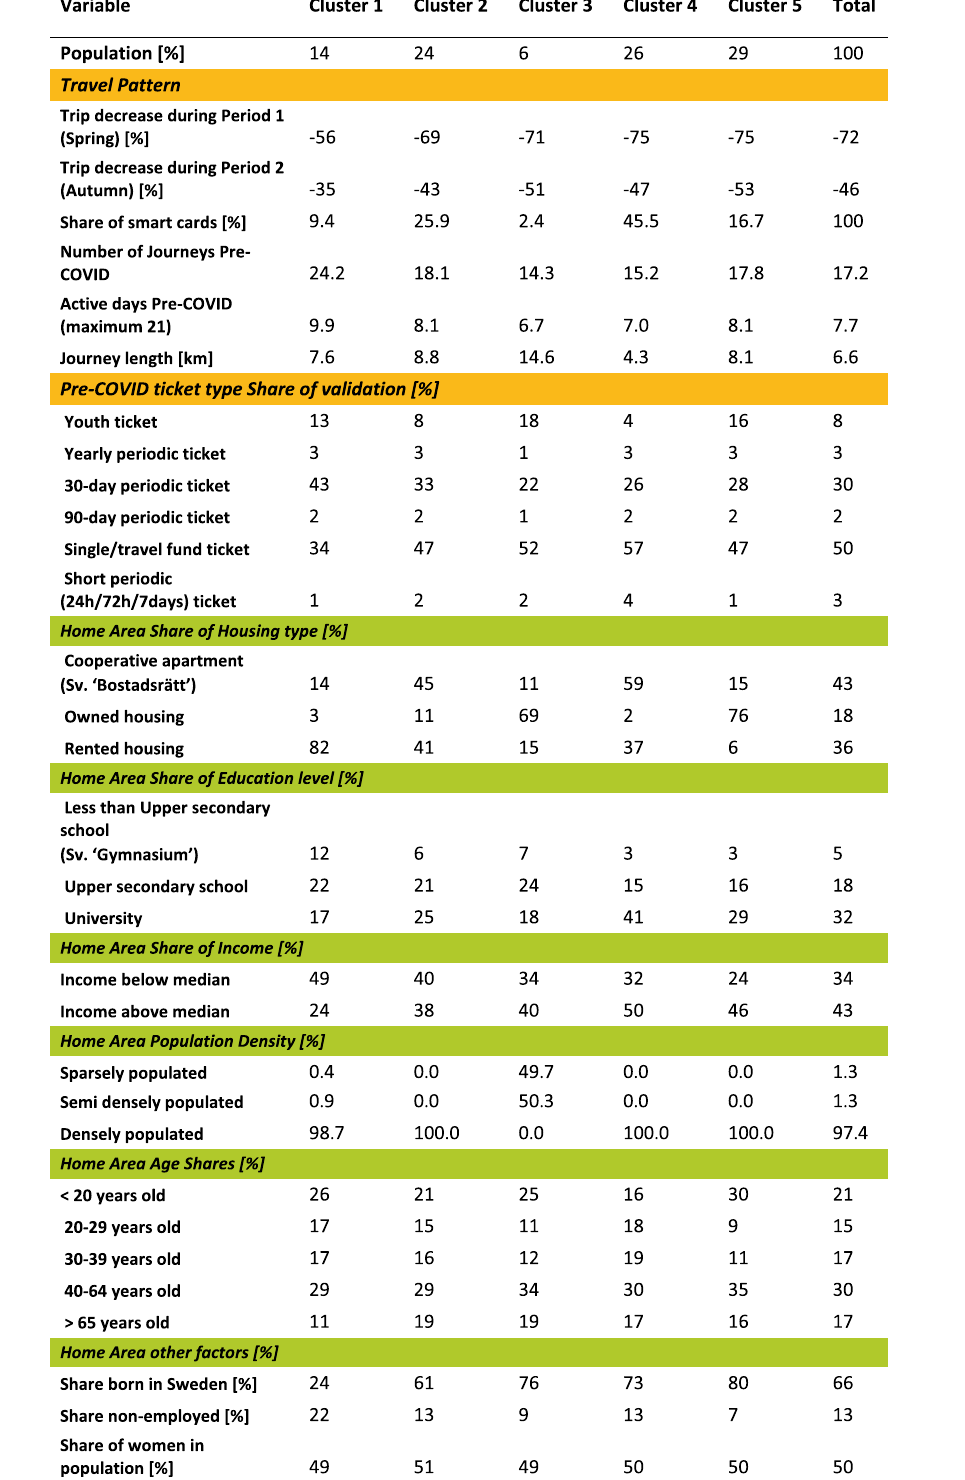
Table 2 The full dataset has 1.8 million individual cards, where each card has an origin zone, and each zone is designated to one of the five clusters. This tabulation describes the average card, and its origin zone attributes, from each of the five clusters and the full set. Travel patterns and ticket types are shown as yellow and socioeconomic variables as